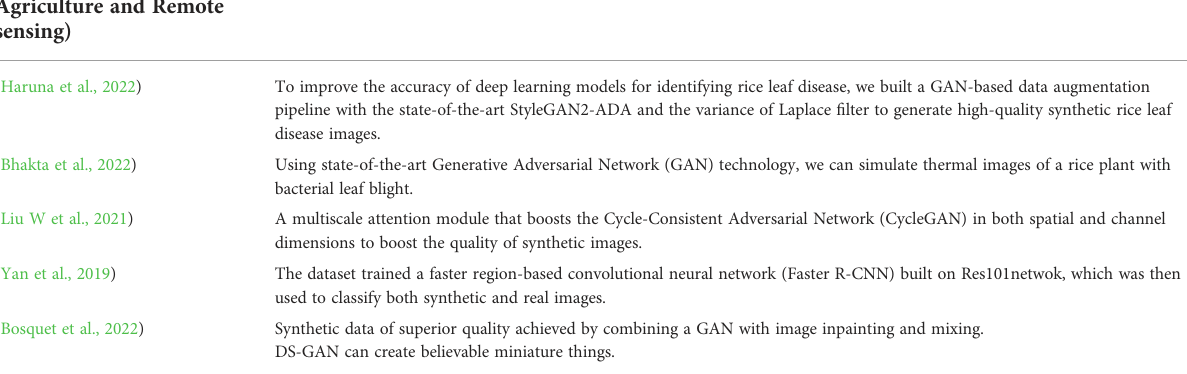
TABLE 4 Data Augmentation-based object detection in Multimedia, Agriculture and Remote sensing. Reference (Multimedia, Agriculture and